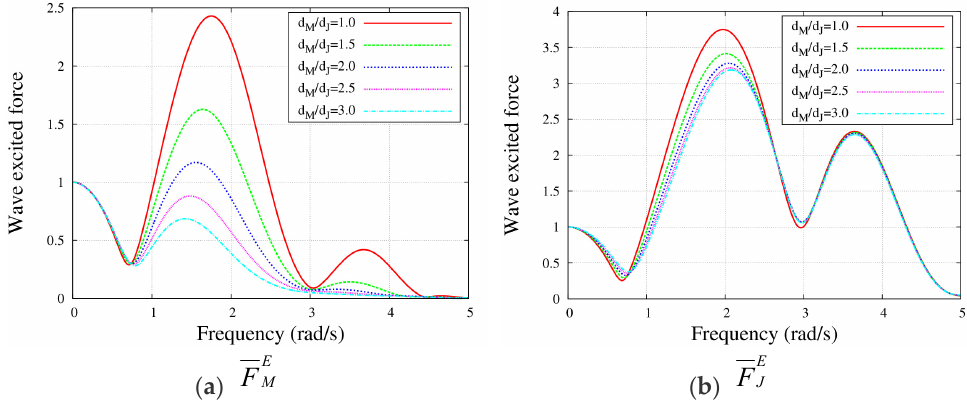
Figure 6. Variation of wave force with frequency on moon pool platform and sea javelin for different draft ratios.